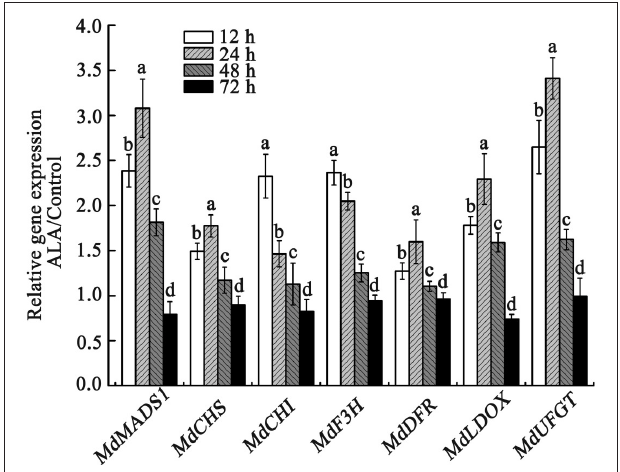
FIGURE 5 | qRT-PCR analysis of the expression of MdMADS1 and anthocyanin biosynthetic genes in apple skin under ALA treatment. The relative expression of MdMADS1 and anthocyanin biosynthetic genes ( MdCHS, MdCHI, MdF3H, MdDFR, MdLDOX, MdUFGT ) were simultaneously analyzed in apple skin with ALA treatment at 12, 24, 48, and 72h light duration. The expression level of each gene in control was used as a reference sample at each time point.